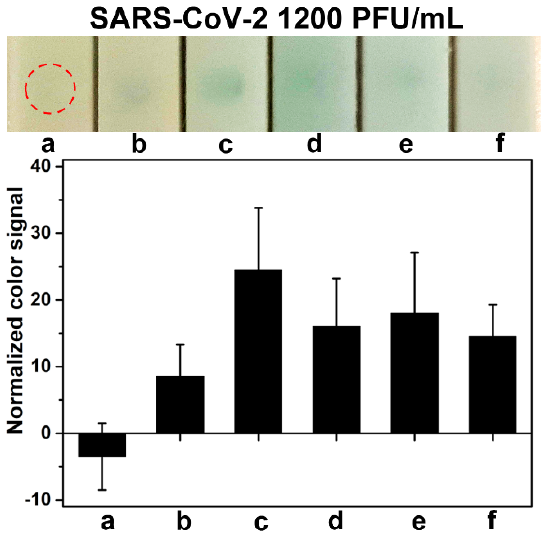
Figure 3. Detection results and the normalized colorimetric signal from 1200 PFU/mL of SARS-CoV-2 in PBS buffer with 1.5 picomoles (a, 142.8 %RSD), 3.0 picomoles (b, 56.5 %RSD), 7.5 picomole (c, 37.9 %RSD), 15 picomoles (d, 45.0 %RSD), 30 picomoles (e, 50.6 %RSD), and 60 picomoles (f, 33.1 %RSD) of magnetic probes ( n = 3) The red-dotted circle overlaid on the image indicates the position where the anti-spike antibody was applied on the LF strip for the test with 1.5 picomoles of magnetic probes.